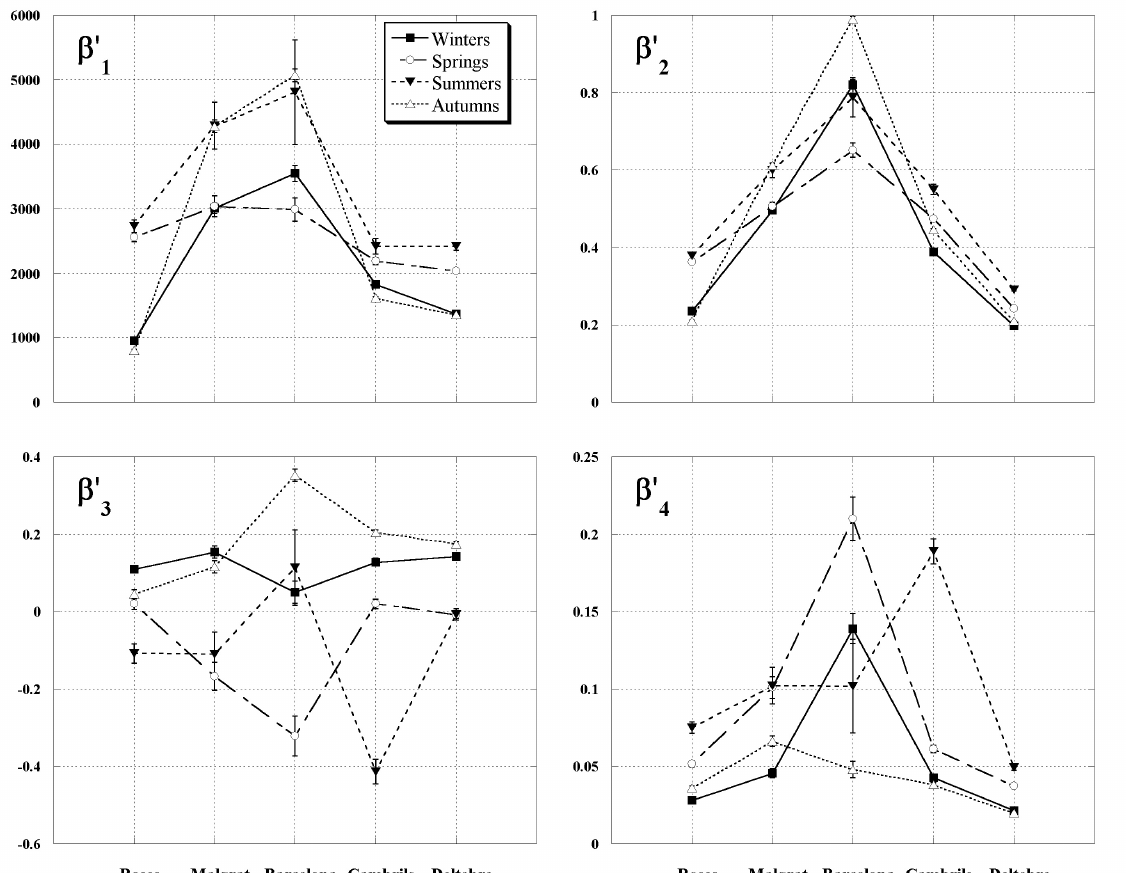
F IG . 5. – Parameter estimations for the Eq. 7 model. Error bars are 95% confidence intervals. Squares: winter; circles: spring; full triangles: summer; empty triangles: